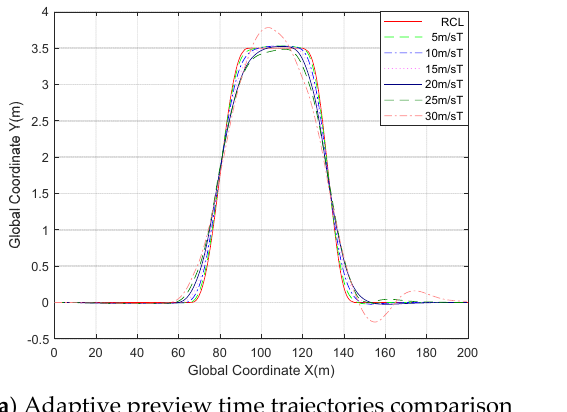
( b ) Comparison of tracking error for different speeds of adaptive preview time Figure 11. Comparison of trajectories and tracking error for different speeds of adaptive preview time.